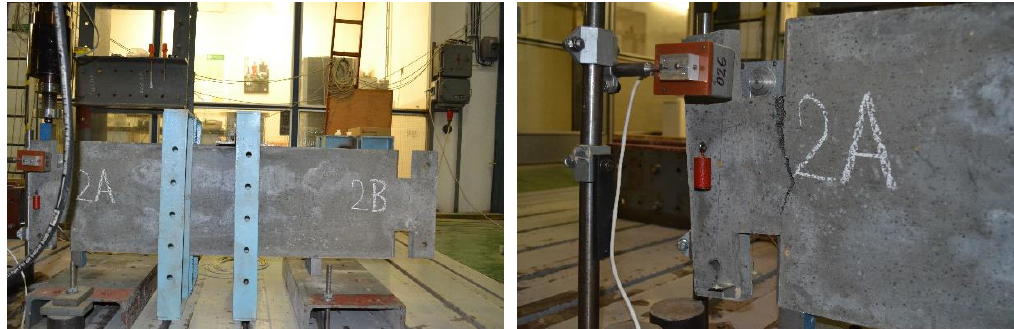
Figure 5. Experimental shear test campaign.